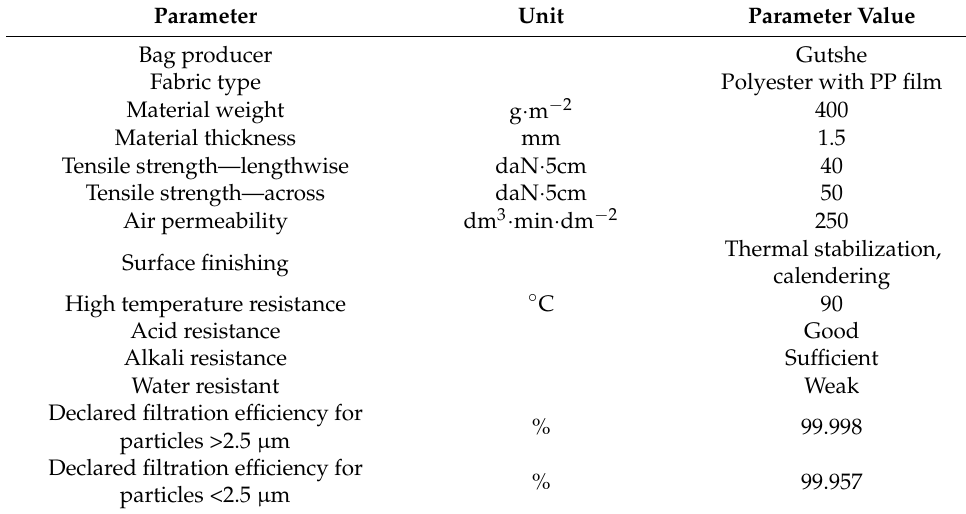
Table 3. Basic technical properties of the filter bags according to the